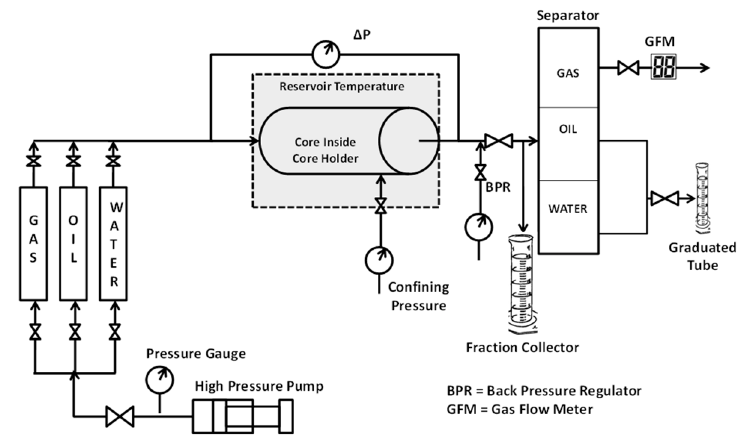
Figure 2. Typical forced imbibition experiment [11].